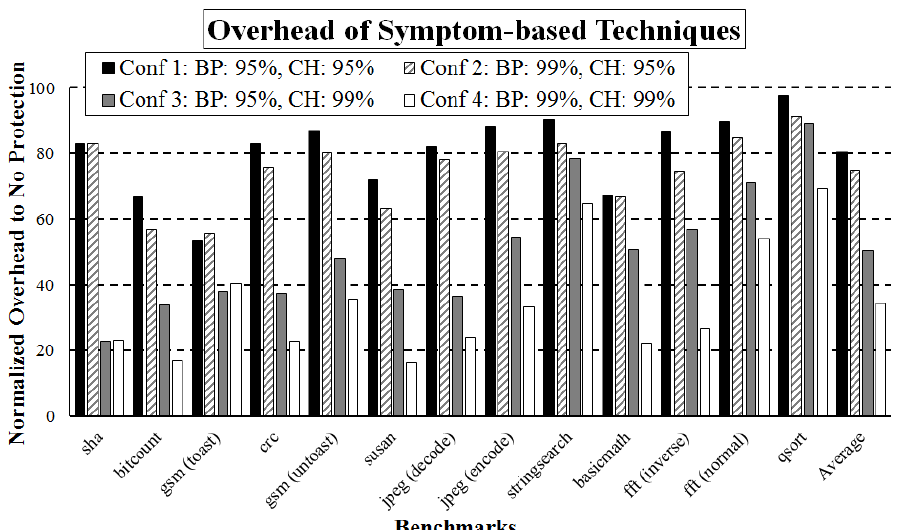
Figure 7. Runtime overheads of symptom-based techniques depend on the accuracy of the branch predictor and cache hit ratio. Even though we have exploited 99% accurate branch predictor and cache memory, the performance overhead is more than 40% as compared to unprotected architectures. (Conf, configuration options; BP, accuracy of branch prediction; and CH, cache hit